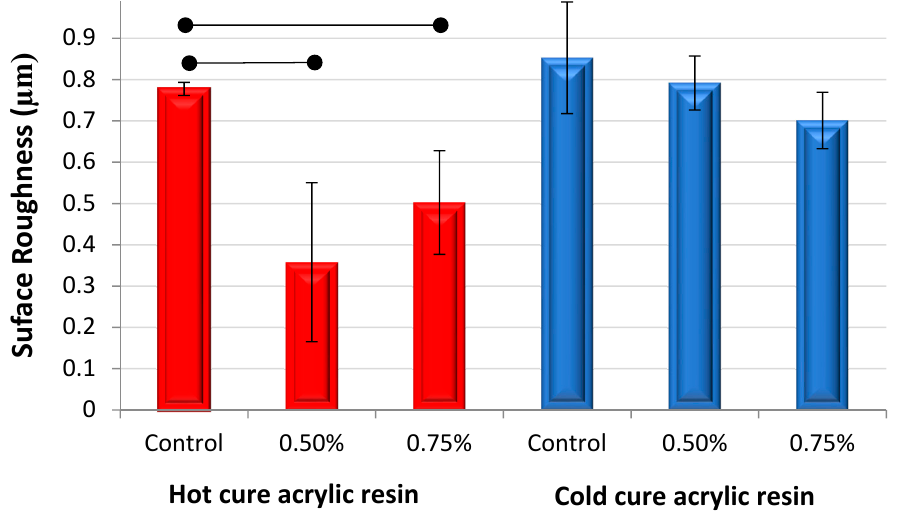
Figure 6. Bar chart showing the differences between the mean surface roughness values in the HC and CC acrylic resins incorporated with Ag-Zn zeolite at different concentrations (0.50 wt.% and 0.75 wt.%) and without any Ag-Zn zeolite (control group). Horizontal lines connecting two bars indicate statistical significance ( p < 0.05).